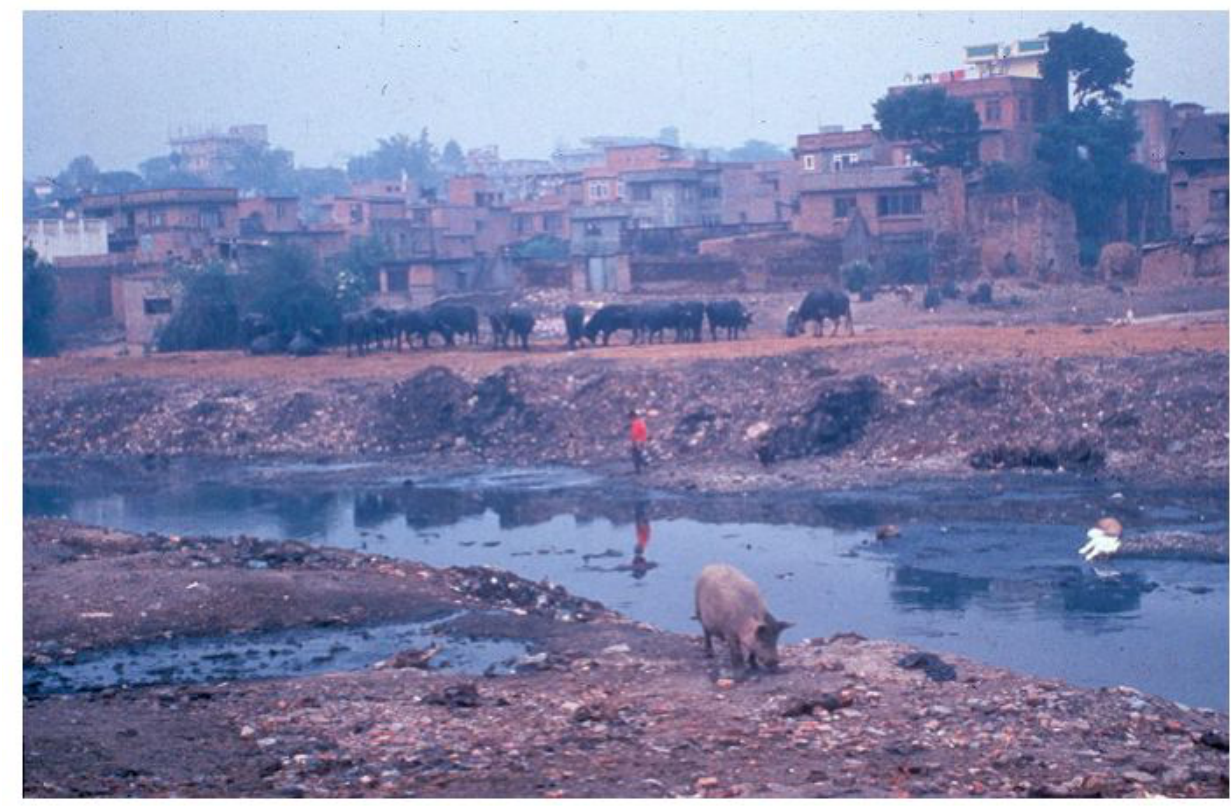
Fig. 2 . The bank of the Bishnumati River adjacent to Wards 19 and 20, Kathmandu,